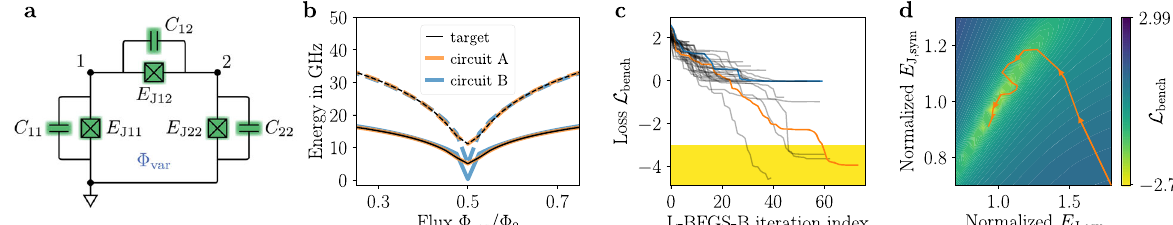
Fig. 2 Flux qubit benchmark. a Parametrized circuit layout to which the circuit designer is constrained. b Target spectrum generated from a C-shunt fl ux qubit design, showing the transition energy from the ground state to the fi rst (solid) and second (dashed) excited state. The fi nal spectra of a successful (orange) and a stuck (blue) re fi nement run are also shown. c Convergence of 40 re fi nement runs starting at randomly sampled initial circuit parameters. d Visualization of a slice of the loss surface corresponding to the benchmarking problem. The orthogonally projected path of a successful re fi nement run towards the global minimum is shown.